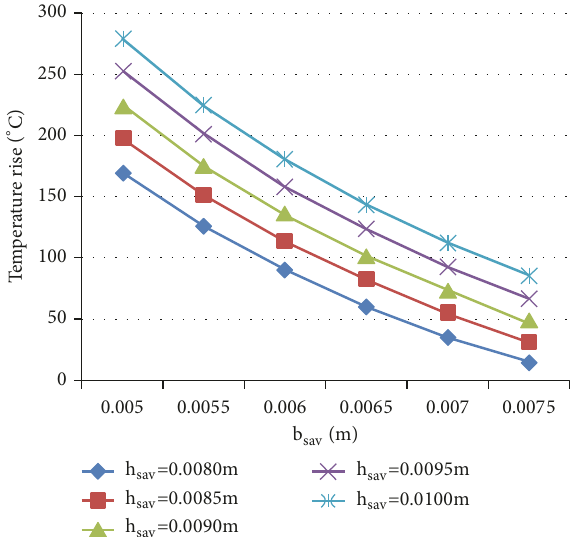
Figure 3: Thecurvesof temperaturerisein statorslot versus b h . sav